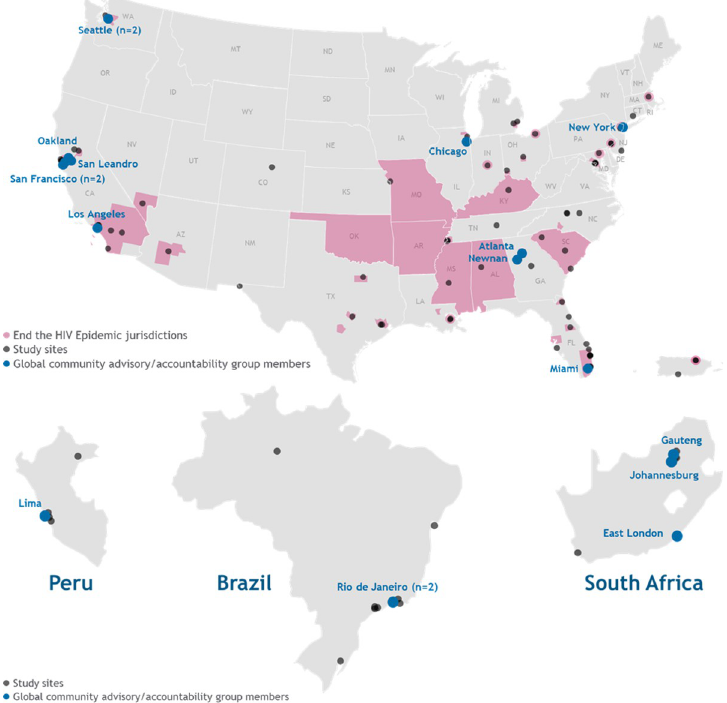
Fig 1. PURPOSE 2 clinical trial study sites and locations of Global Community Advisory and Accountability Group (GCAG) members.